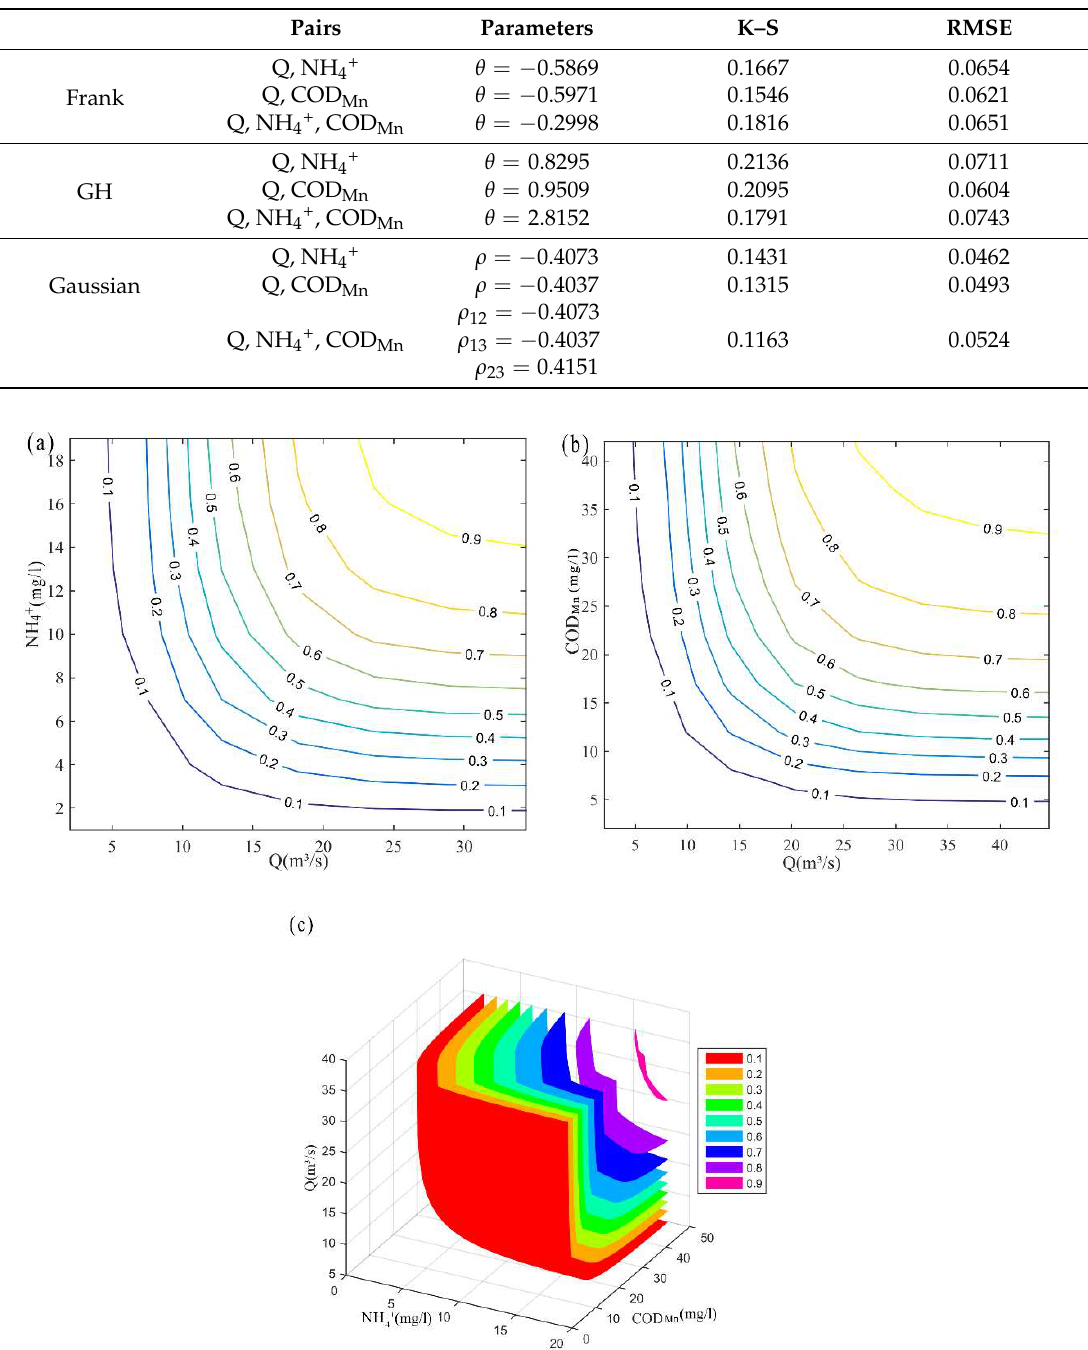
Table 5. The parameters of copulas of Q, NH 4+ , and COD Mn and the results of K–S and RMSE.